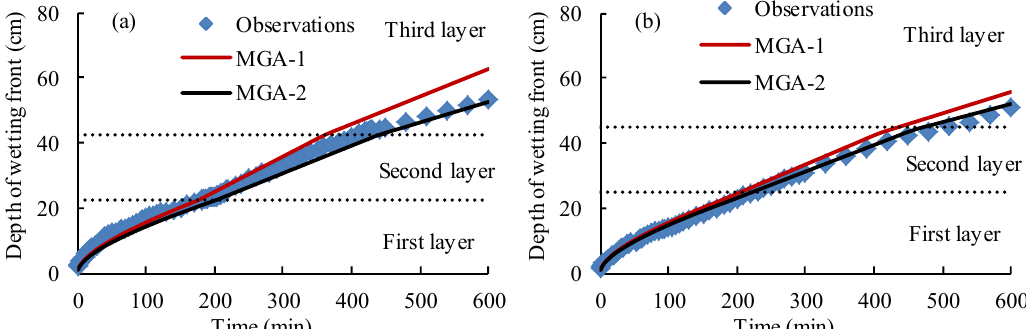
Figure 13. Comparison of the observed wetting front advancement and the calculated value with the